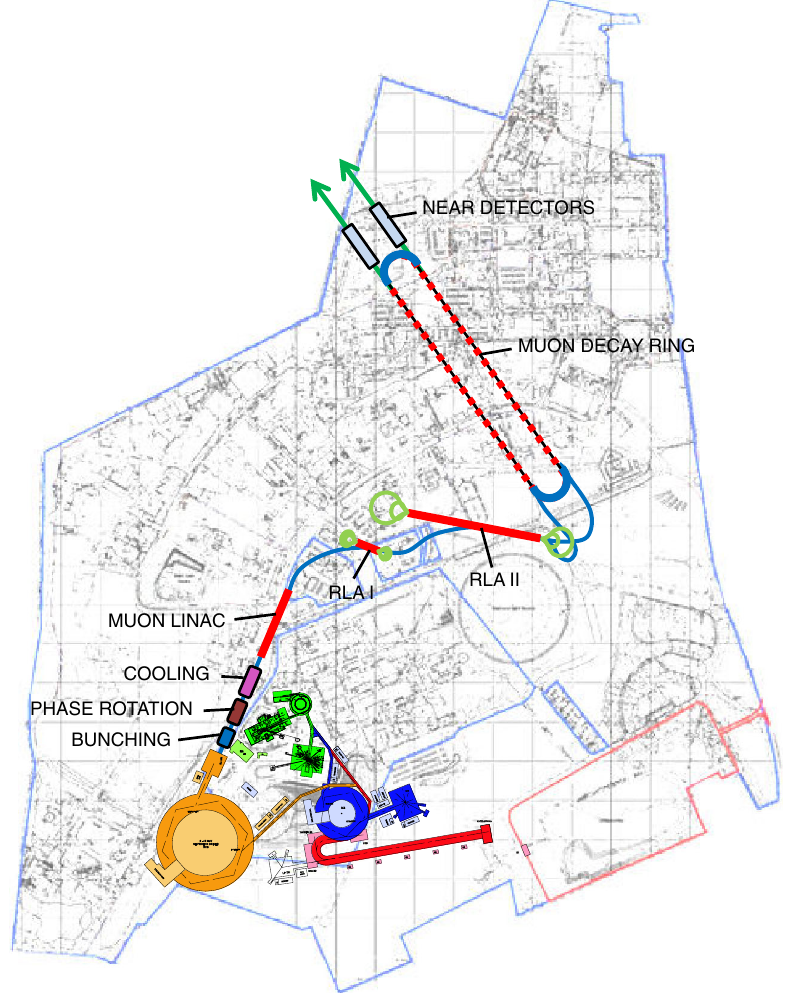
FIG. 6. Schematic layout of the NF on the Harwell Oxford site with neutrino beams pointing at Norsaq in Greenland. The proton driver is as shown in Fig. 5 and the Harwell Oxford site boundary is shown in bright